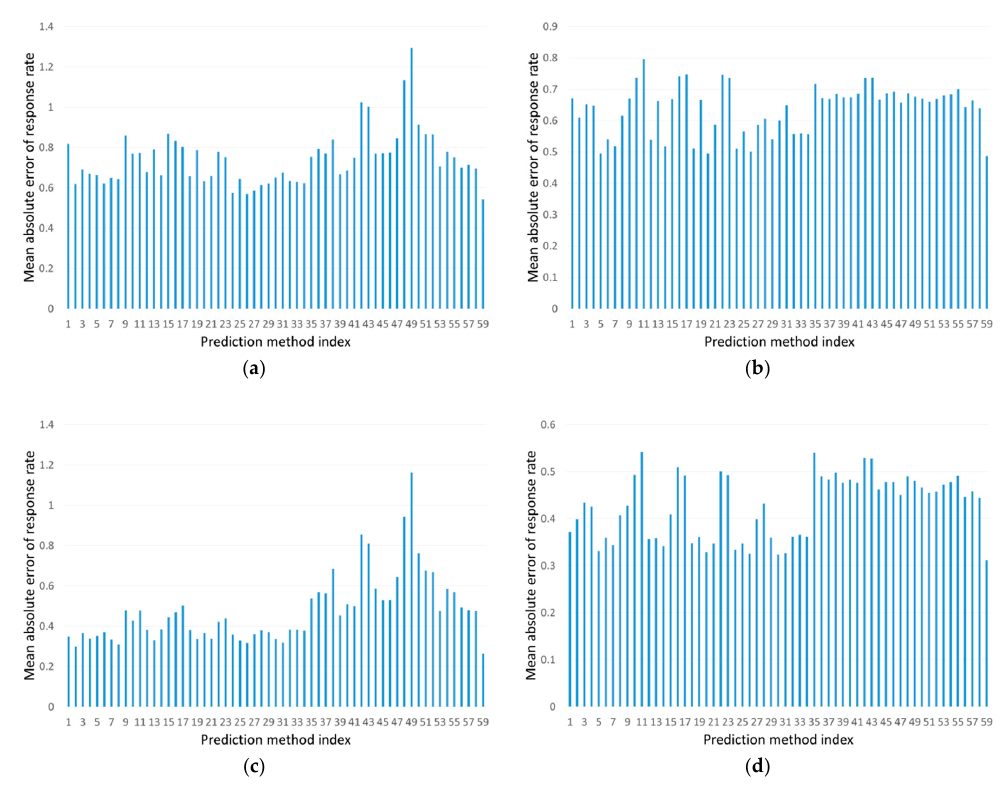
Figure 7. Prediction error comparison with other various methods. (Index 1: averaging; index 59: the proposed method). ( a ) Customer set A (From service provider A); ( b ) Customer set B (From service provider B); ( c ) Customer set A (Outliers eliminated); ( d ) Customer set B (Outliers eliminated).